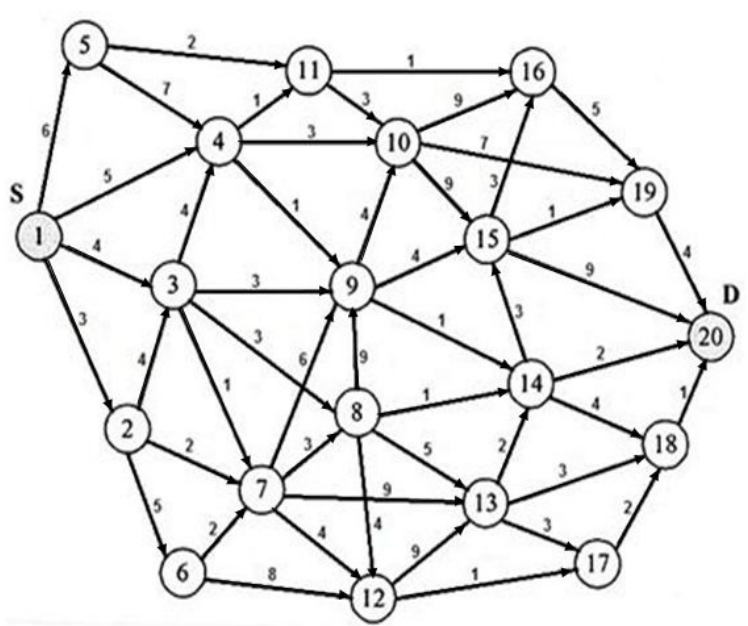
Figure 4. A graph with 20 nodes and 49